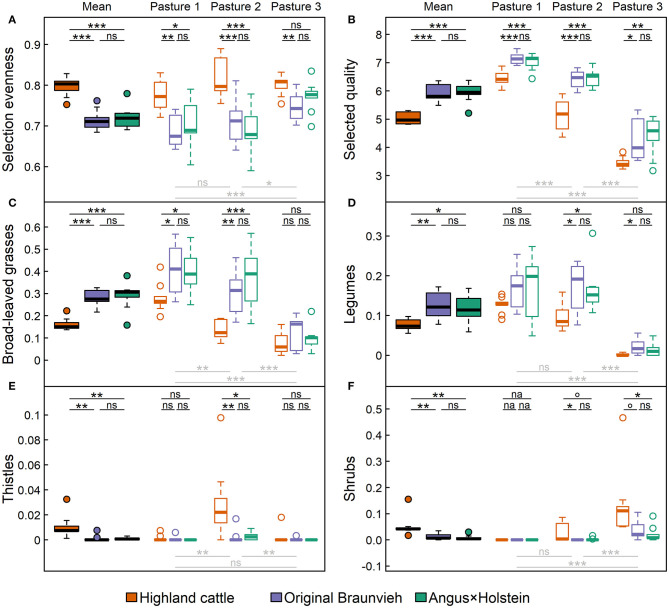
Forage selection behavior of three cattle breeds Angus × Holstein, Original Braunvieh, and Highland cattle. For all the nine cows per breed (A) the evenness of forage selection, (B) the average forage quality of the selected plants (21), and the share of (C) broad-leaved grasses, (D) legumes, (E) thistles, and (F) shrubs within the selected forage plants were measured. Filled boxplots represent average values, empty boxplots differentiate by the three types of alpine pastures: (1) nutrient-rich, flat pasture, (2) heterogeneous dwarf-shrub pasture, (3) nutrient-poor fen and wood pasture. Significances of differences among breeds are displayed above the boxplots in black, those among pastures below the boxplots in light gray [box: 25th to 75th quartile range (IRQ); line: median; whiskers: max. 1.5 × IQR; points: outliers; nsp > 0.1; °p < 0.1; *p < 0.05; **p < 0.01; ***p < 0.001, na, not available].